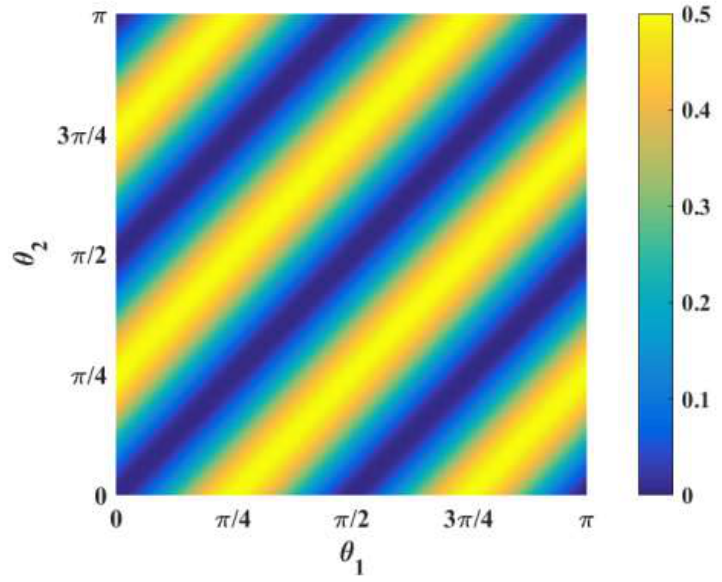
Figure 4. Relationship between σ 2 / EWV and fast axis azimuth angles ( θ 1 , θ 2 ) of QWP.